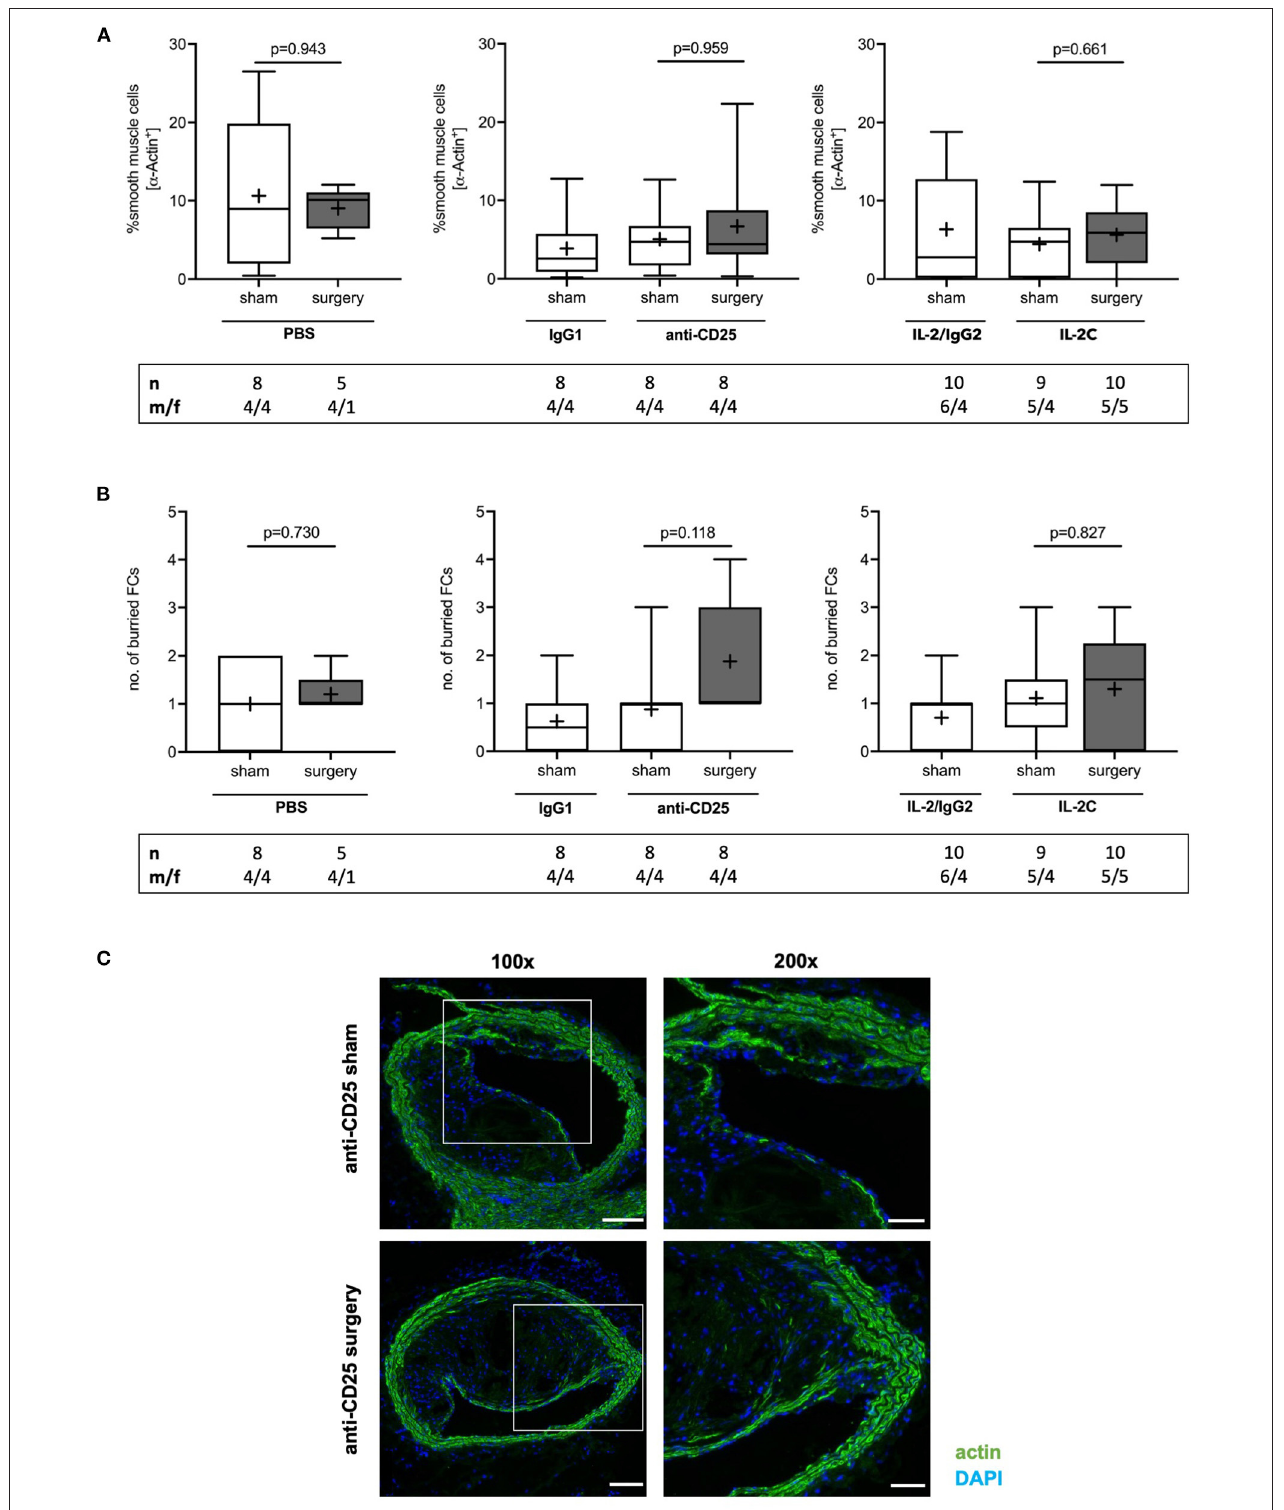
FIGURE 6 | Effect of preoperative Treg levels on smooth muscle cell (SMC) content and number of buried fibrous caps (FC). (A) SMC content was quantified as the area staining positive for α smooth muscle actin relative to total plaque area. at the site of maximum stenosis (B) Lesional SMC-rich layers were